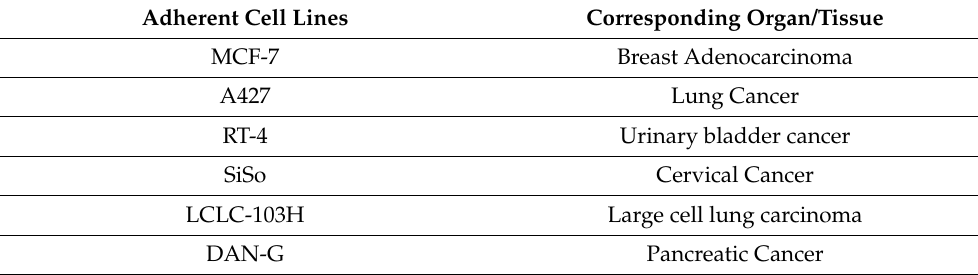
Table 4. Cancer cell lines